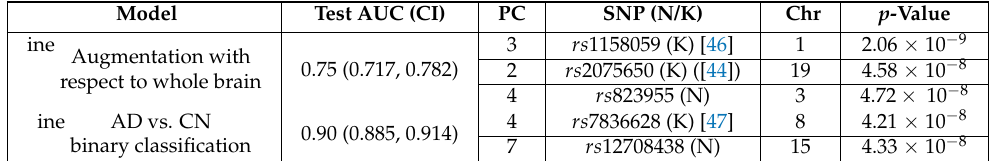
Table 1. Models based on whole-brain images with test AUCs (95% confidence intervals (CIs)) as well as contributing principal components and significant SNPs with their chromosomal positions and p -values. Novel and known SNPs are indicated by N and K,